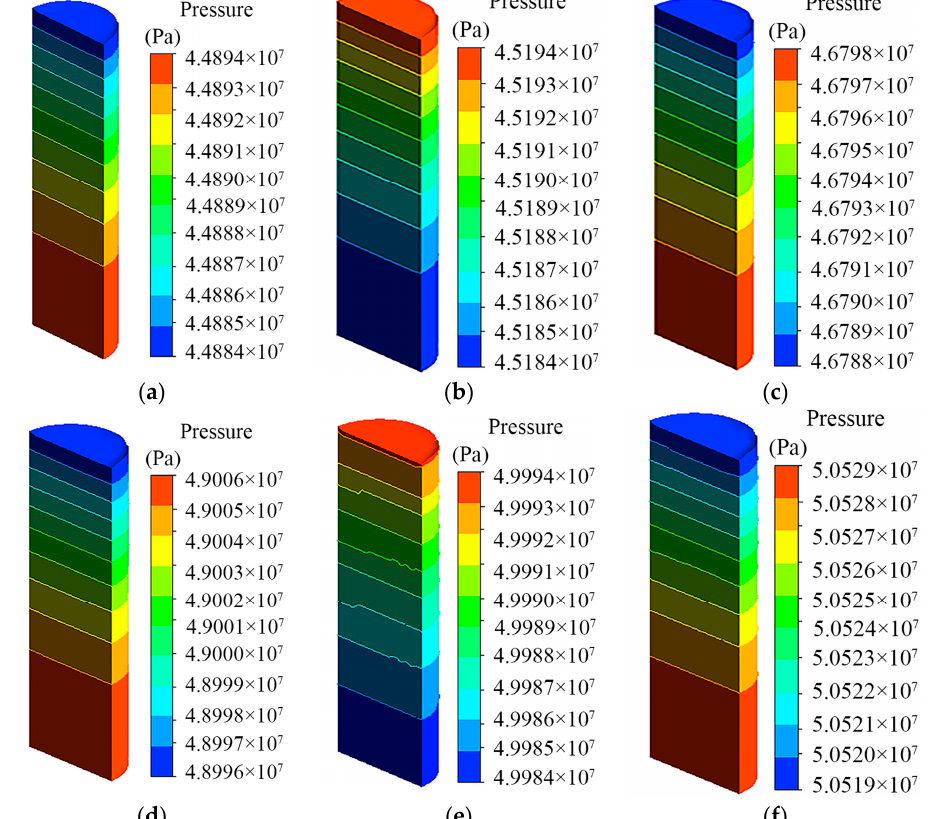
Figure 15. ( a ) Pressure distribution in the fluid domain of the two-level cylinder under condition ( a ). ( b ) Pressure distribution in the fluid domain of the two-level cylinder under impact 0.01 s. ( c ) Pressure distribution in the fluid domain of the two-level cylinder under impact 0.02 s. ( d ) Pressure distribution in the fluid domain of the two-level cylinder under impact 0.03 s. ( e ) Pressure distribution in the fluid domain of the two-level cylinder under impact 0.04 s. ( f ) Pressure distribution in the fluid domain of the two-level cylinder under impact 0.05 s.